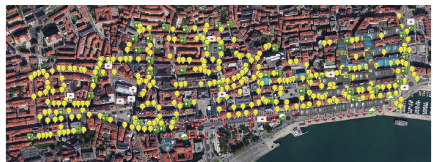
Figure 5: SmartSantander sensors